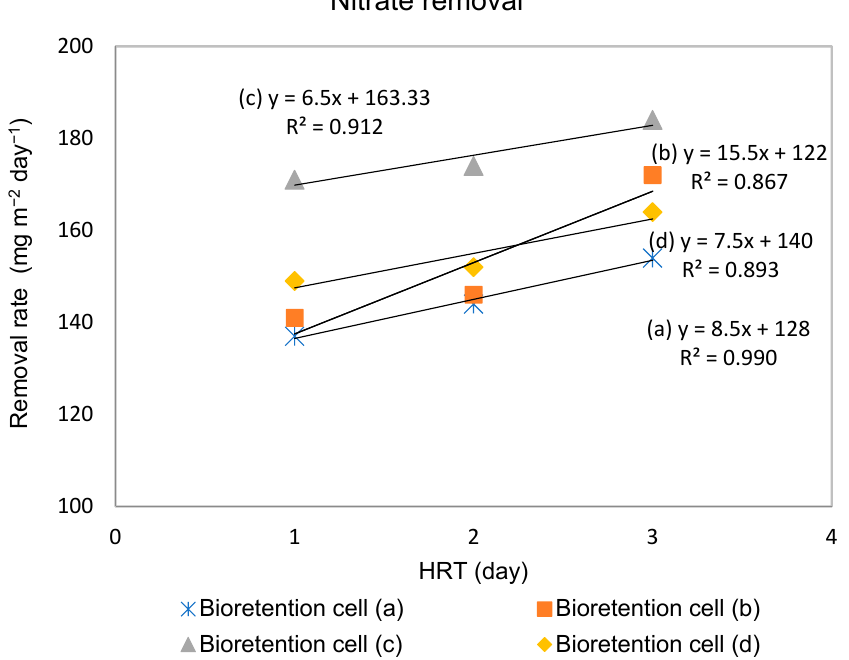
Figure 3. Correlation between nitrate removal rate (mg m − 2 day − 1 ) and HRT (day). Table 3. The mean effluent concentrations of nitrogen and phosphorus (mg L − 1 ) for bioretention mesocosms.